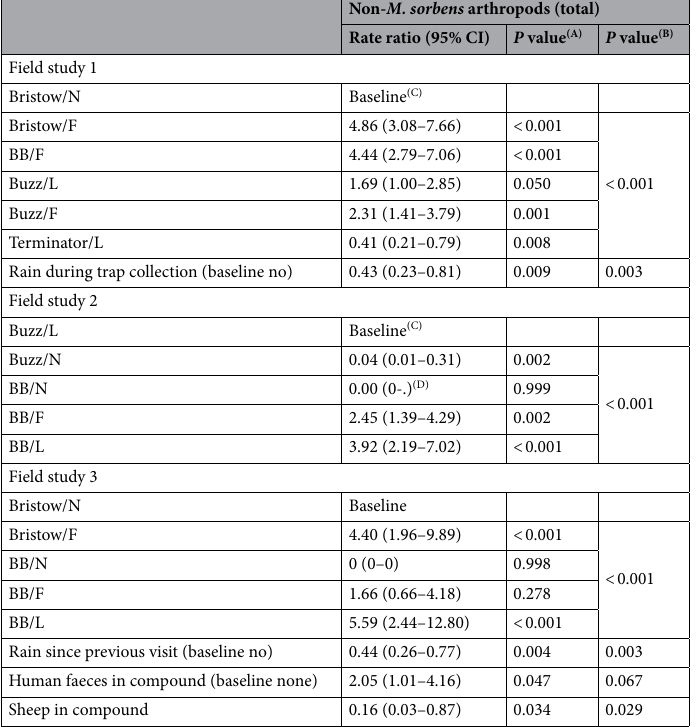
Table 3. Non- M. sorbens arthropods caught by different trap types across three field studies. Trap types are: Bristow trap/negative (Bristow/N; no bait), Bristow/faeces (Bristow/F), Bickford Bucket/faeces (BB/F), The Buzz/The Buzz lure (Buzz/L), The Buzz/faeces (Buzz/F), Buzz/negative (Buzz/N [water]), Terminator/ Terminator lure (Terminator/L), Bickford Bucket/negative (BB/N) Bickford Bucket/ The Buzz lure (BB/L). (A) P -value comparing this category with baseline. (B) P -value testing hypothesis that trap type is associated